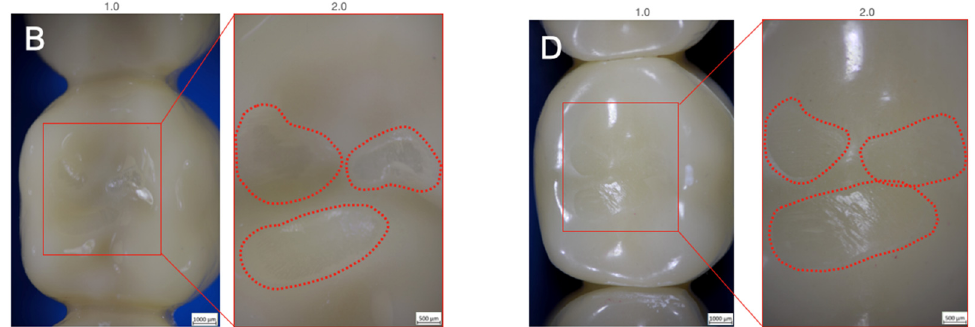
Figure 3. Superficial wear of glazing material for Groups Z-HT ( A ), Z-ST ( B ) and FL ( C ). Clear wear facets of Group RL ( D ) after cyclic loading.